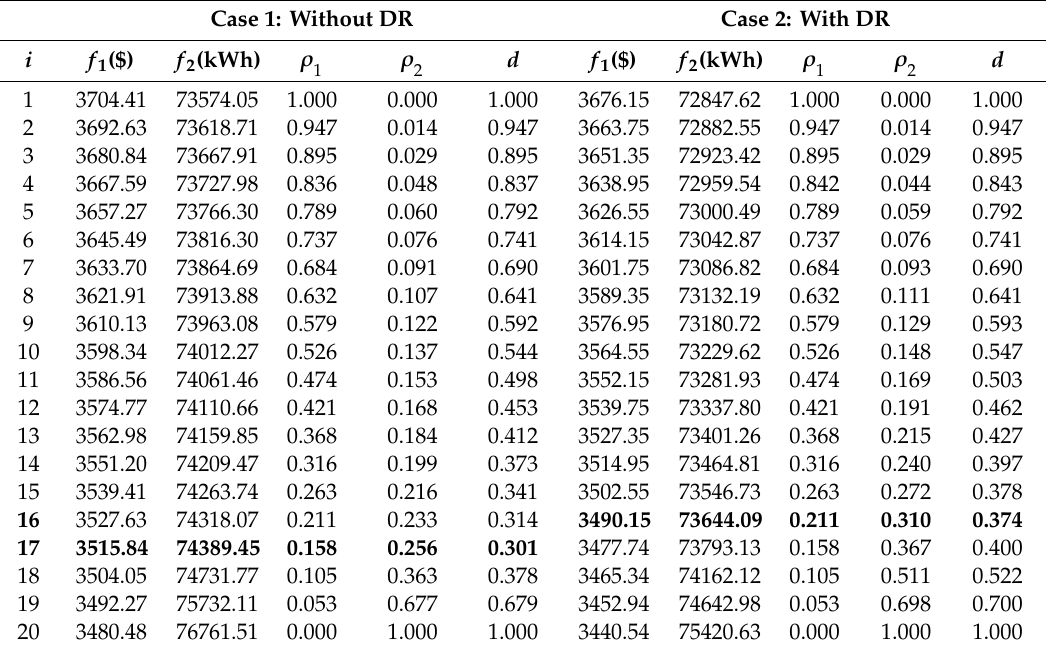
Table 3. Pareto optimal solutions by the ε -constraint